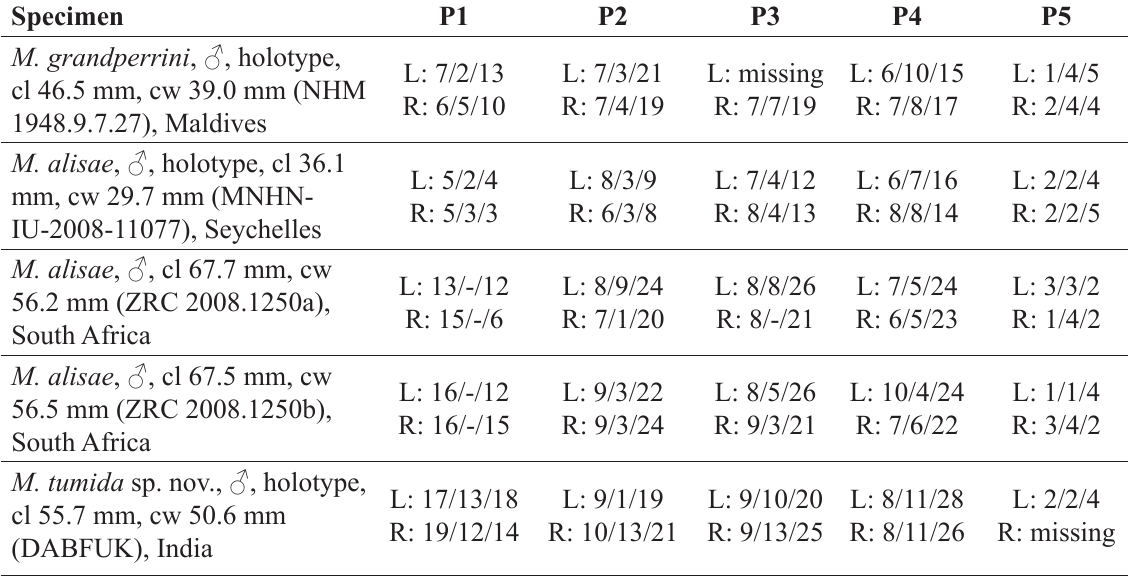
Table 1. Spine counts on margins and surfaces of the meri of P1–P5 of Moloha species. The counts are given in the following order: dorsal margin / outer surface / ventral margin. L and R are for left and right sides,